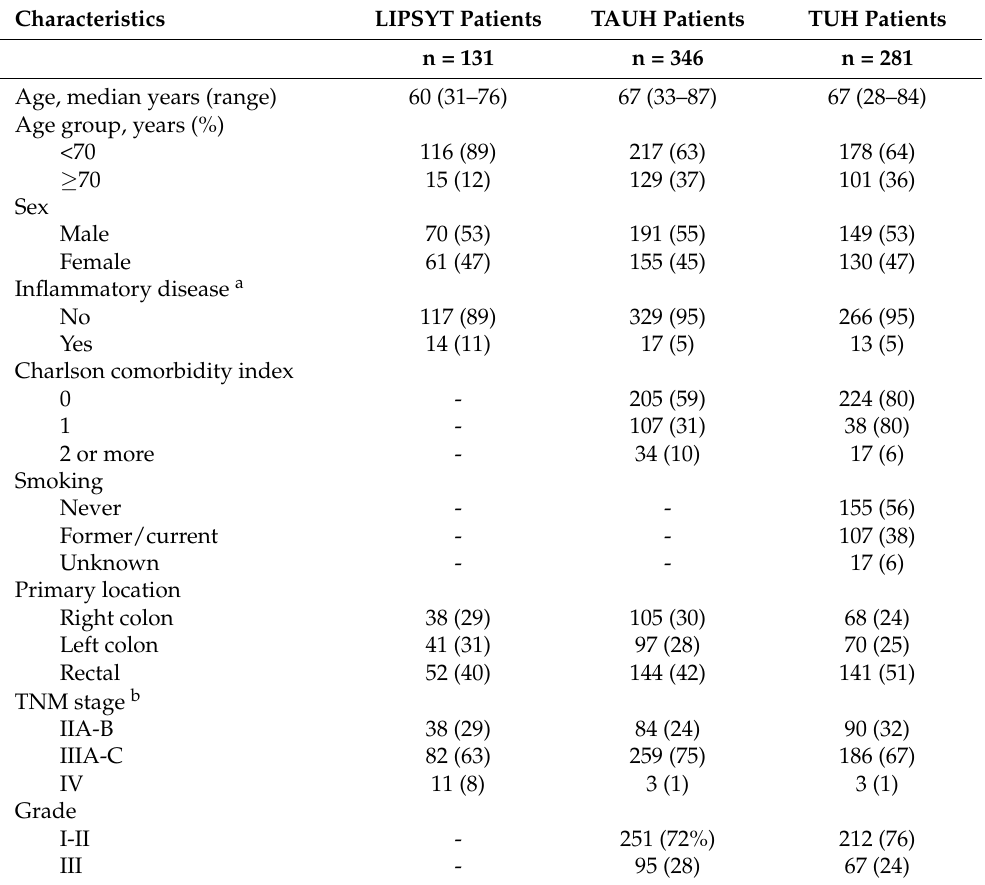
Table 1. Patient and tumour